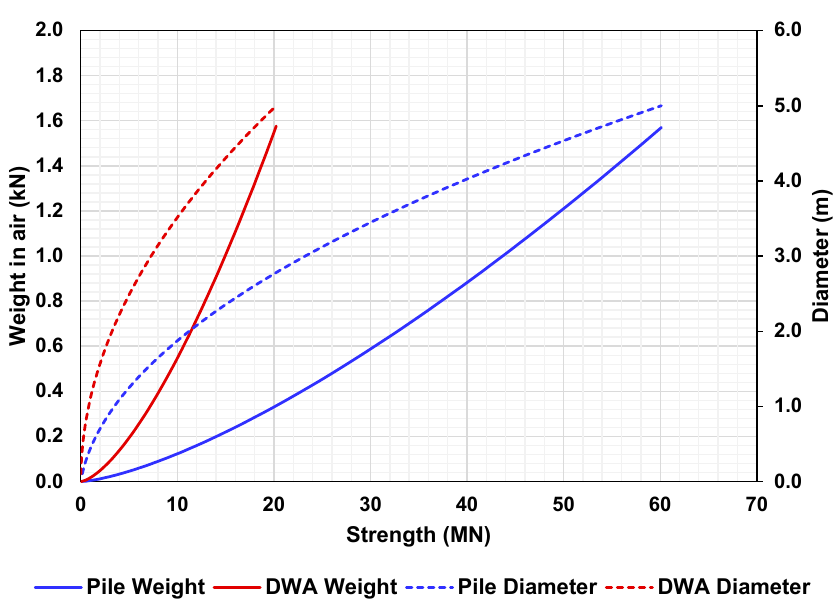
Figure 9. P–Y curve of pile application example.